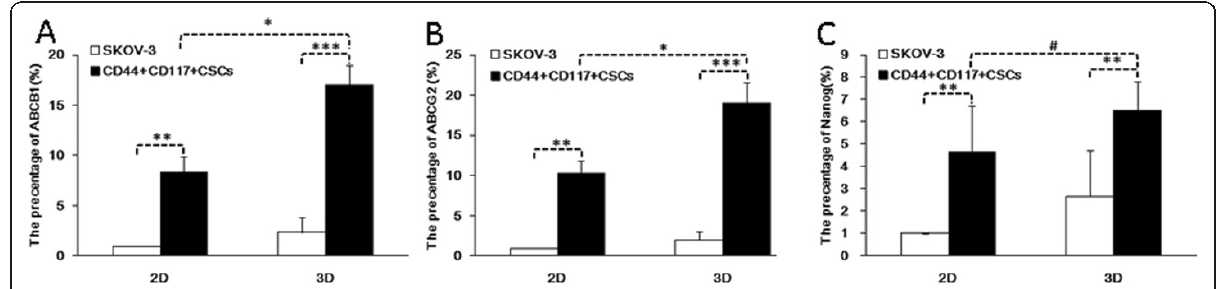
Figure 6 Expression of ABCG2, ABCB1 and Nanog in the CD44 + 117 + CSCs in 3D culture and 2D cultures. A-C indicate the expression of ABCG2, ABCB1 and Nanog in the CD44 + 117 + CSCs and SKOV-3 cells respectively, as they were cultured in the 3D or 2D culture medium detected by qRT-PCR. Statistically significant differences are indicated by asterisk (*) for P <0.05, (**) for P < 0.03, (***) for P < 0.01. # indicates P > 0.05